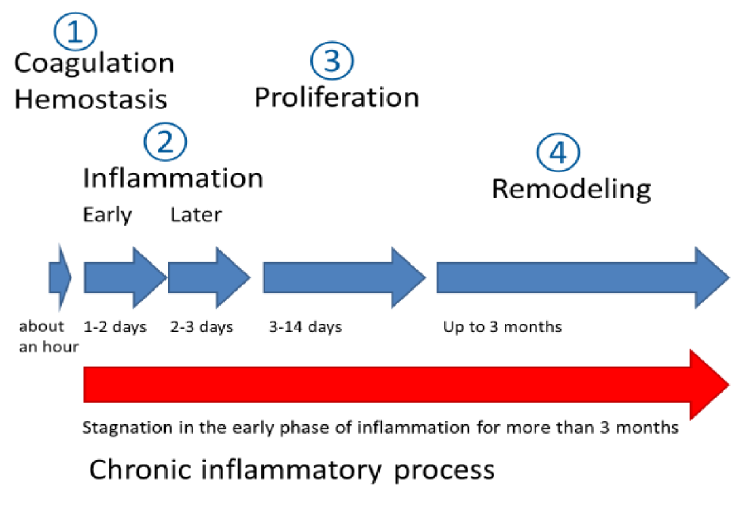
Figure 9. Stages of wound healing process